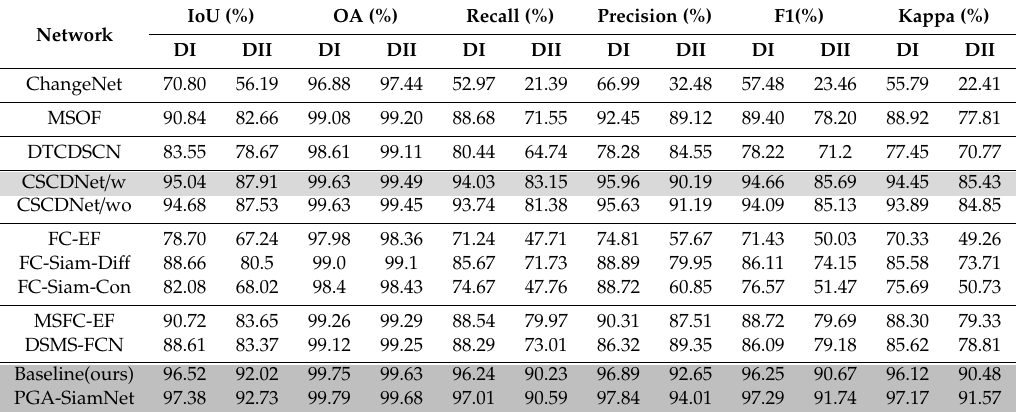
Table 3. Comparison with other related methods (the lighter shadow represents the best results of other related methods; the darker shadow represents the results of our proposed